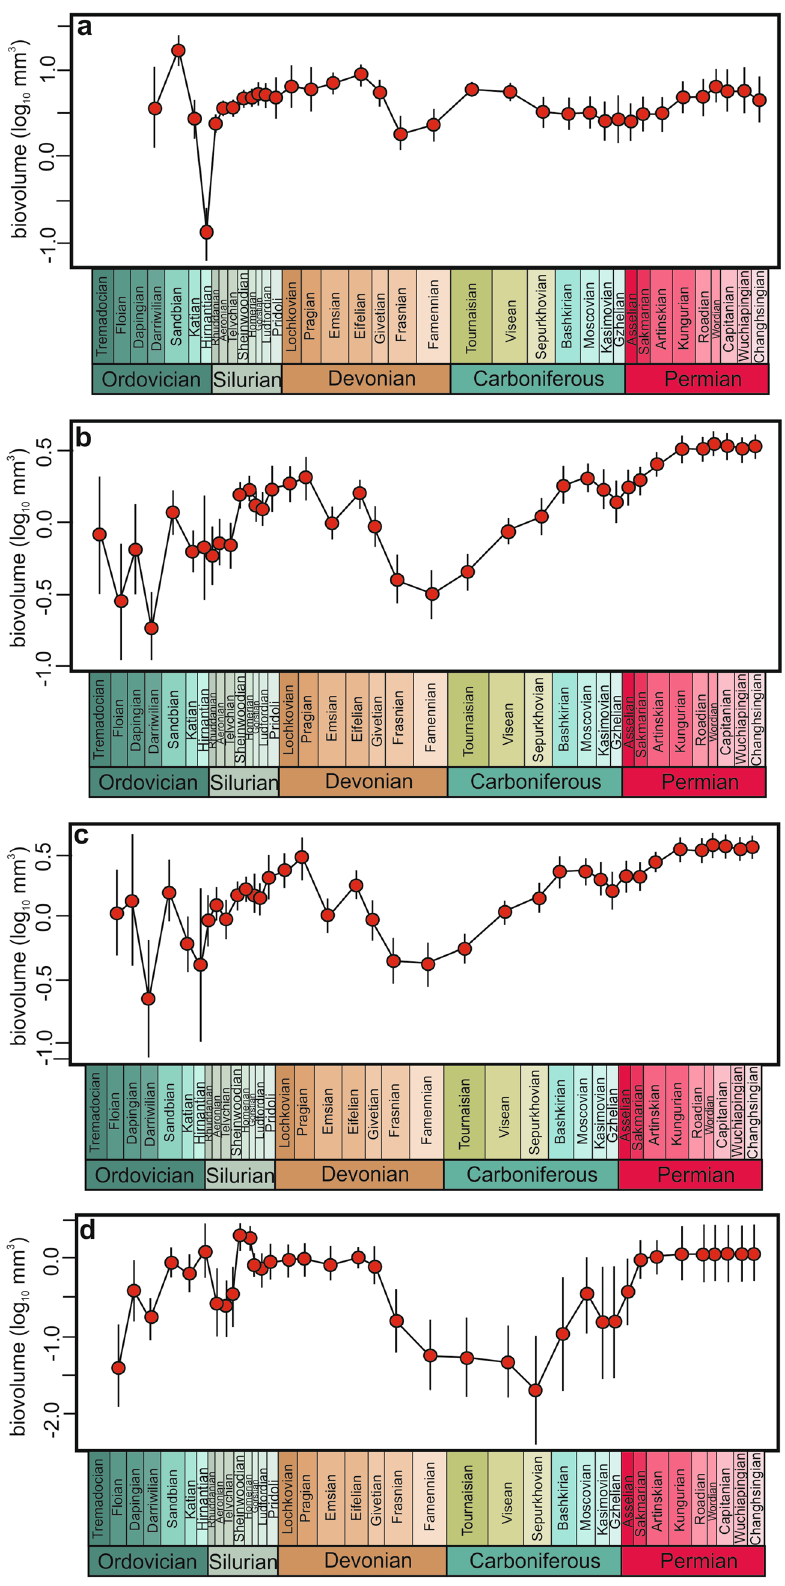
Figure 2. Trends in mean calyx size of major crinoid subclades in the Palaeozoic. (a) Camerata, (b) Pentacrinoidea, (c) Disparida, (d) Cladida. Vertical lines represent error